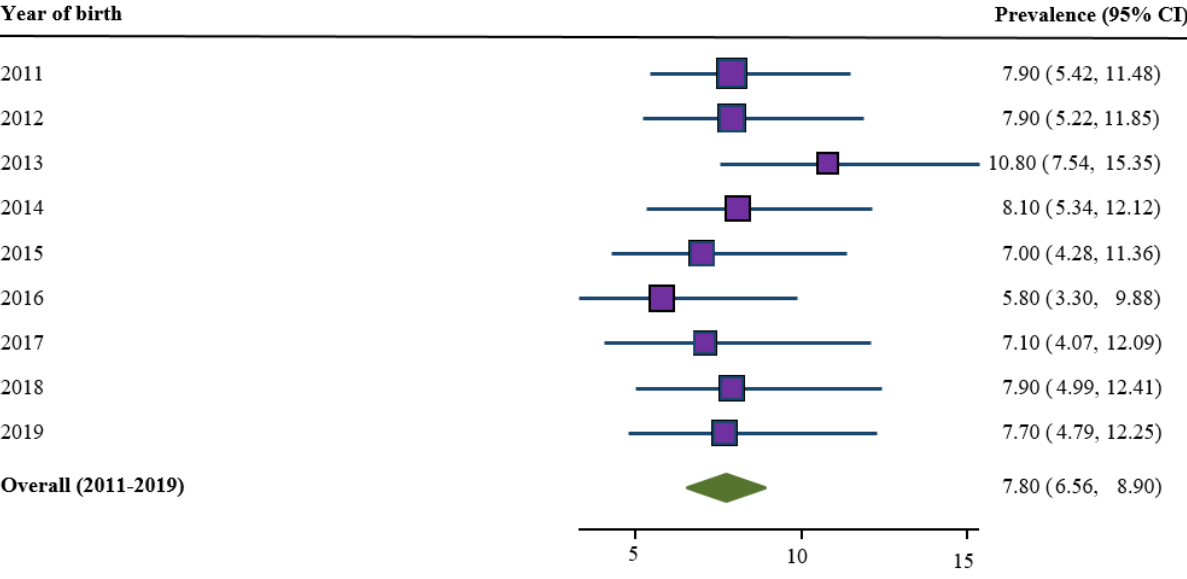
Figure 1. Conceptual framework for the analysis of smoking cessation during the second half of pregnancy and low birth weight (LBW) of babies among mothers of reproductive age (15–49 years).